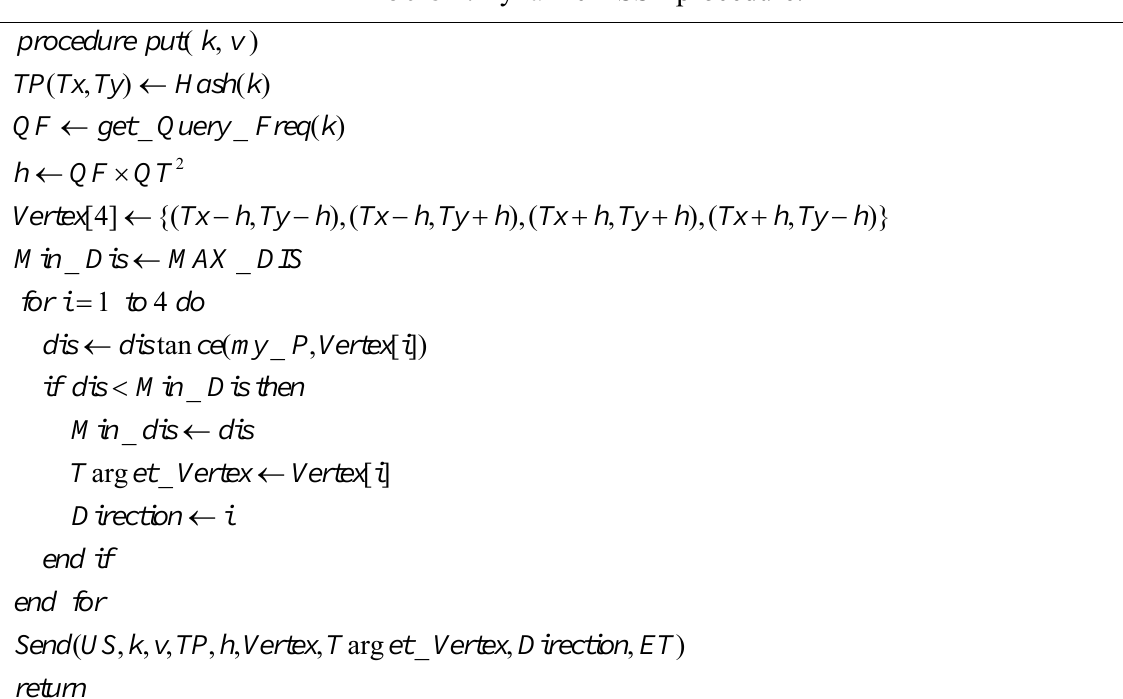
Table 2. Dynamic ASST